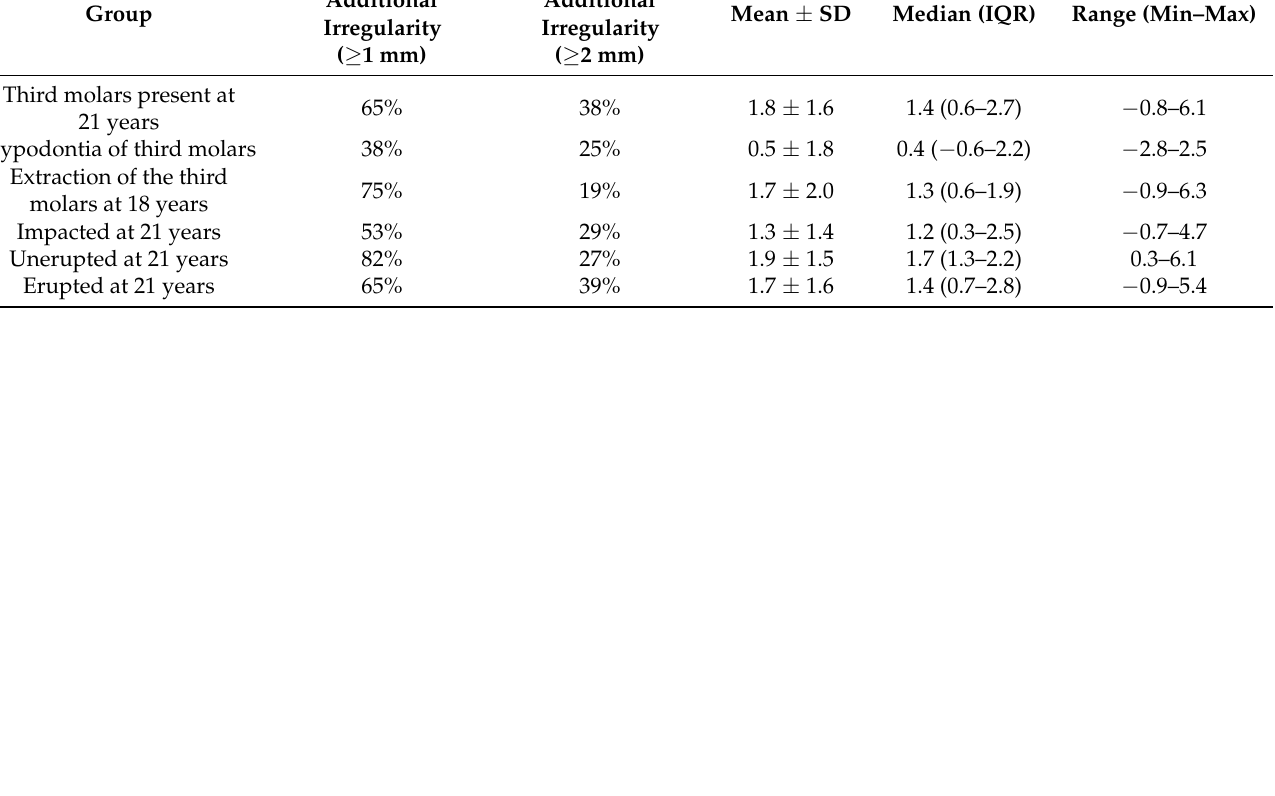
Figure 5. Comparison of change in mandibular incisor irregularity (The irregularity index) from 12 to 21 years between the groups with erupted, unerupted and impacted third molars.